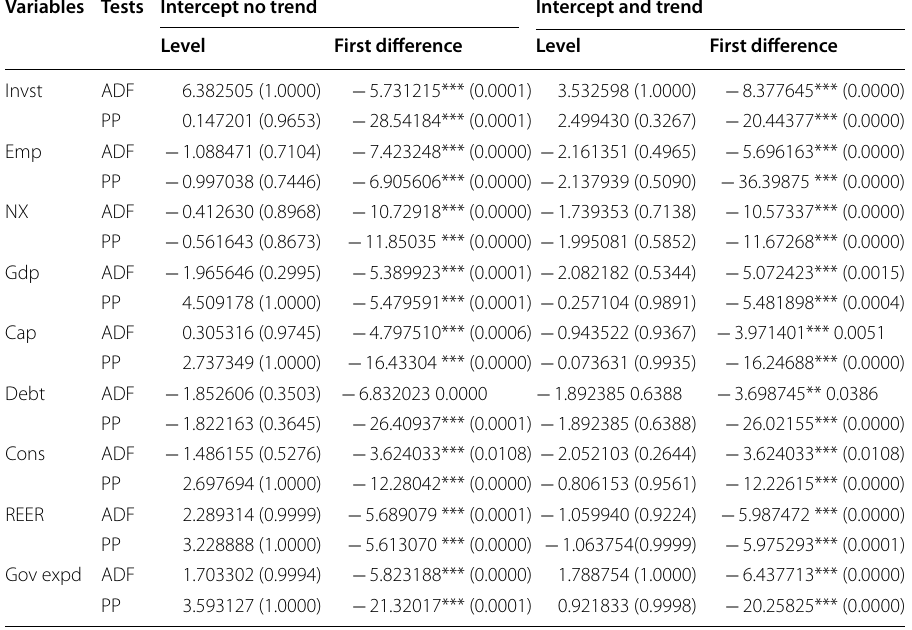
*, **, and *** indicate significance at the 10%, 5%, and 1% levels, respectively